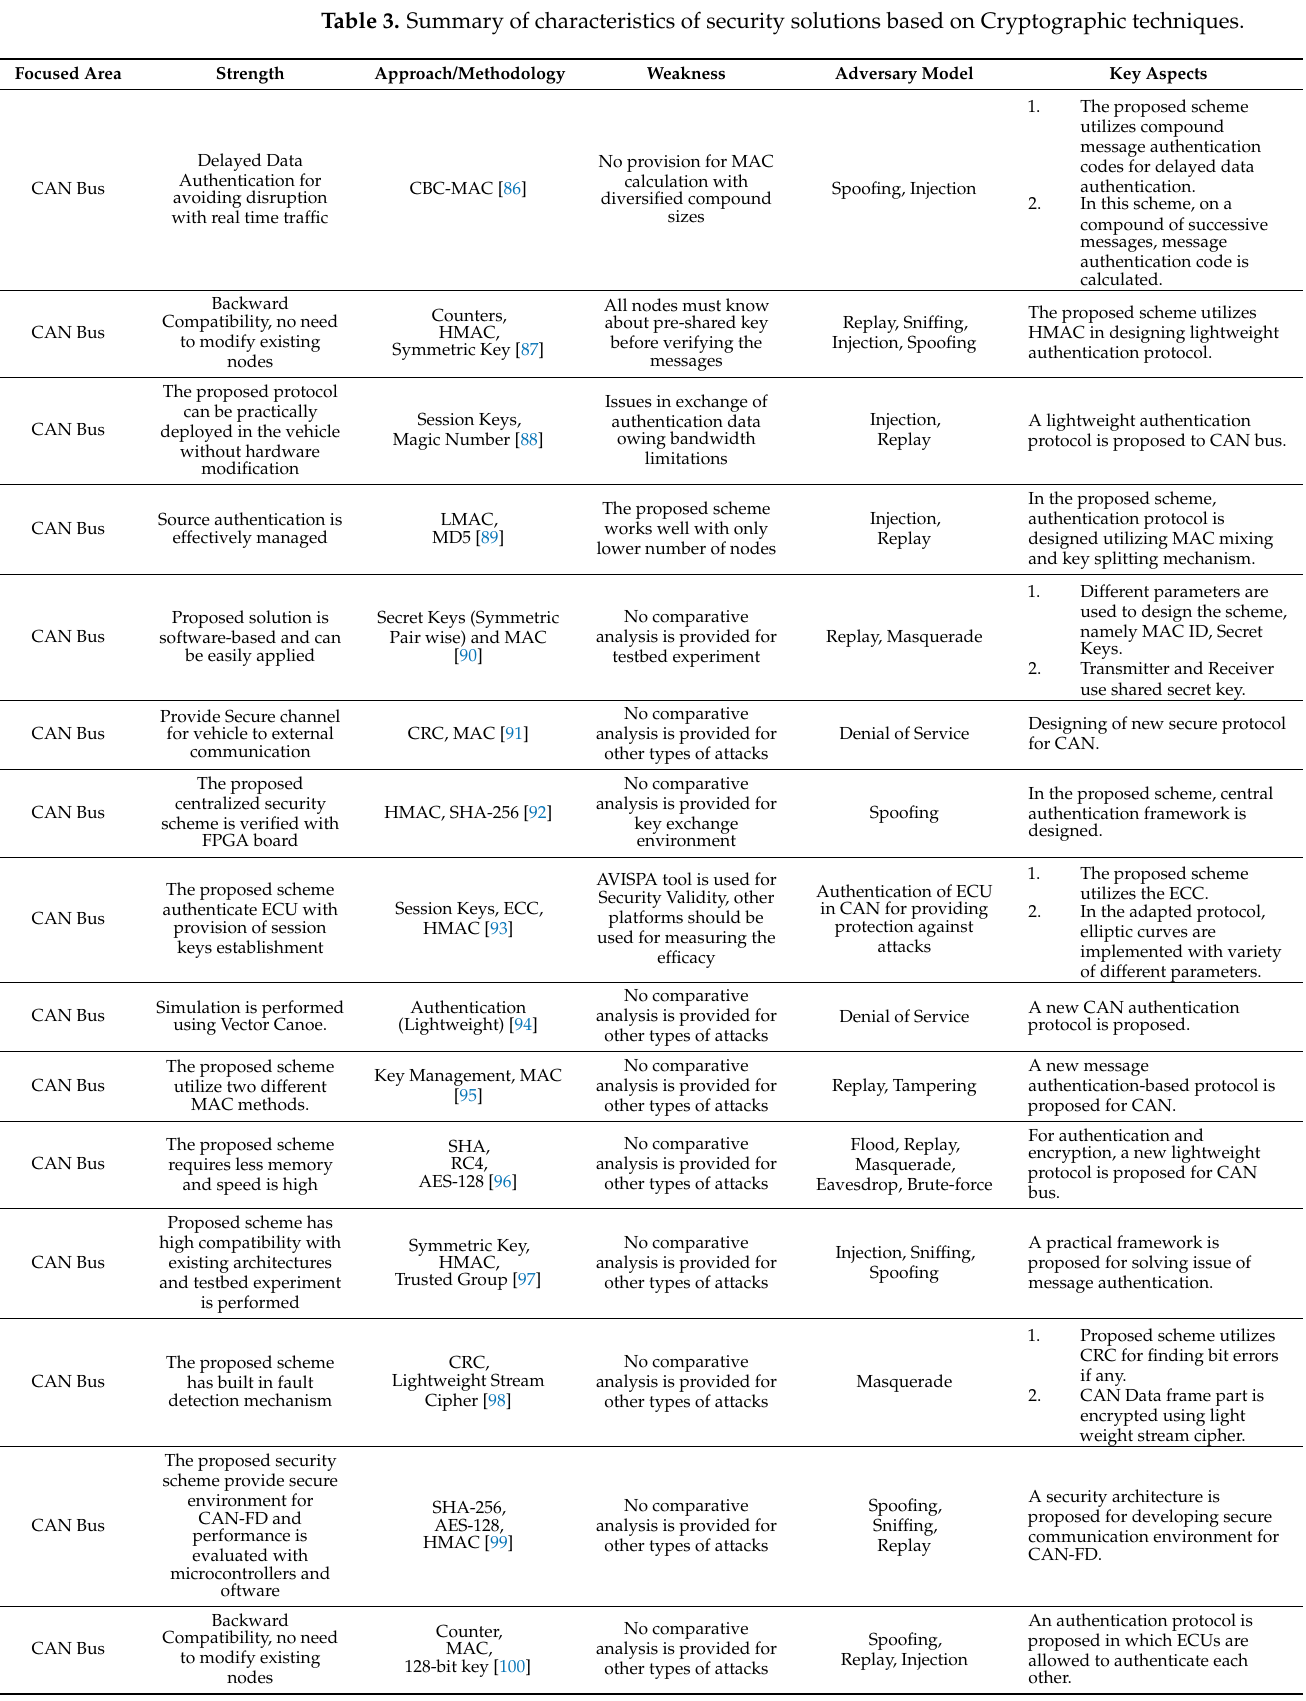
Table 3. Summary of characteristics of security solutions based on Cryptographic